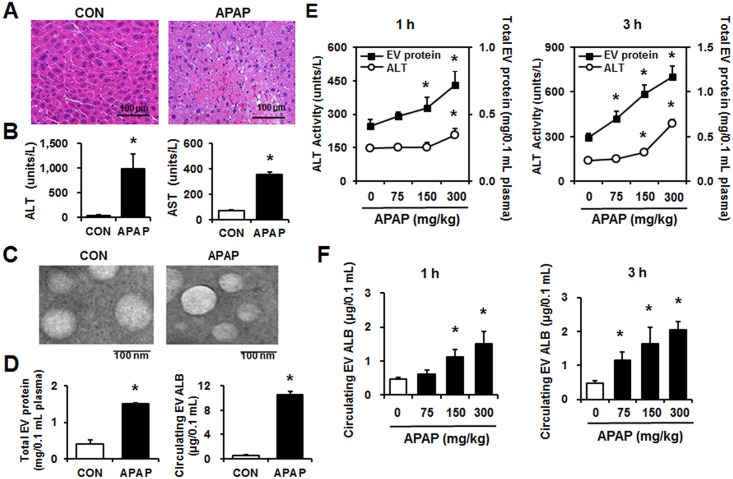
The protein amounts of circulating EVs were increased in APAP-exposed mice.Wild-type male BALB/c mice (6 weeks old) received a single ip injection of APAP (300 mg/kg) or saline control (CON) and were sacrificed after 24 h (n = 10/group). (A) Representative hematoxylin and eosin (H&E) staining of formalin-fixed liver sections. (B) Plasma ALT and AST levels. (C) Representative electron microscopic images of EVs purified from mouse plasma. (D) Analysis of the protein amounts in circulating EVs. The amounts of a liver-specific protein ALB were measured by ELISA specific for mouse ALB. (E) Wild-type male BALB/c mice (6 weeks old) were injected with a single dose of 75, 150, or 300 mg/kg APAP, and the protein amounts in circulating EVs were measured after 1 or 3 h (n = 10/group). The ALT levels are shown on the left while the circulating EV protein amounts are indicated on the right side of each Figure. (F) The amounts of albumin (ALB) in circulating EVs, isolated from plasma of the indicated groups, were measured by ELISA. *P < 0.05.